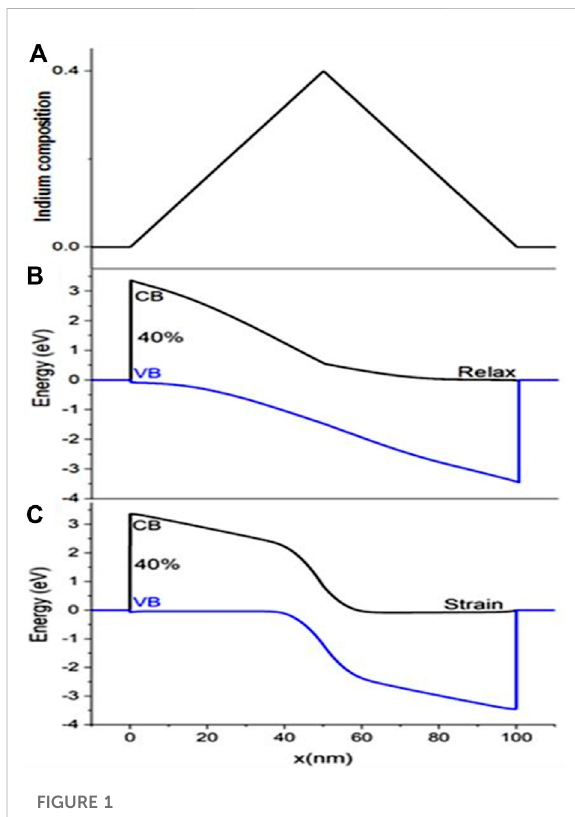
FIGURE 1 (A) Indium composition vs. position. (B) Energy band diagram vs. position (fully relaxed). (C) Energy band diagram vs. position (fully strained) for the Λ -graded structure at x = 40% at room